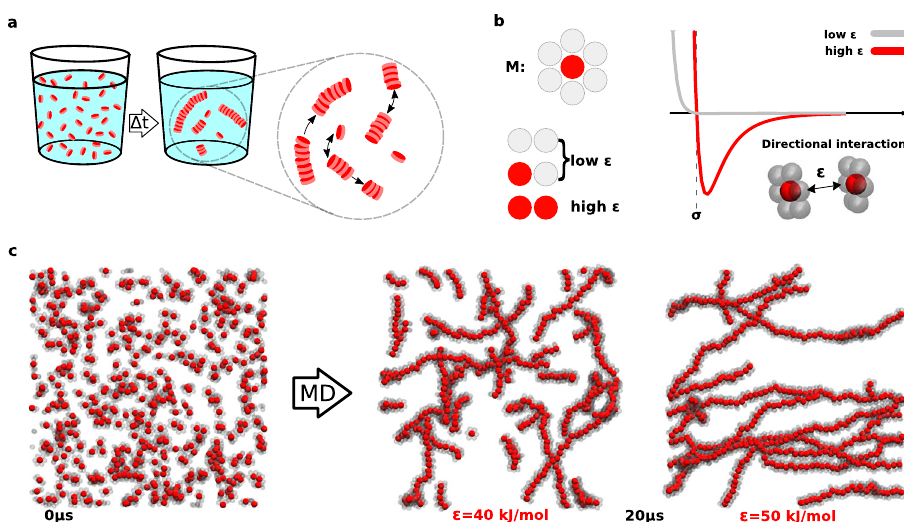
Fig. 1 Minimalistic model of self-assembling monomers M. a Scheme for the self-assembly of monomeric M units into supramolecular polymers. At the thermodynamic equilibrium, the fi bres exhibit a more/less pronounced dynamic behaviour, exchanging units and fragments with each other and with the external environment. b Structure and interaction of the minimalistic model: the M monomers interact directionally via attractive interaction between the central red beads. Weakly interacting beads (in grey) are added to screen the red beads and prevent lateral binding of the monomers (imparting directionality to the M – M interaction). The interactions in the model are de fi ned by Lennard – Jones potentials. c CG-MD simulation snapshots of a model system composed of 500 initially randomly distributed monomers: the two snapshots at t CG = 20 μ s refer to cases with the interaction strength between central beads is set at ϵ = 40 kJ mol − 1 (centre) or ϵ = 50 kJ mol − 1 (right), respectively, (both model systems start from the same initial condition, on the left).